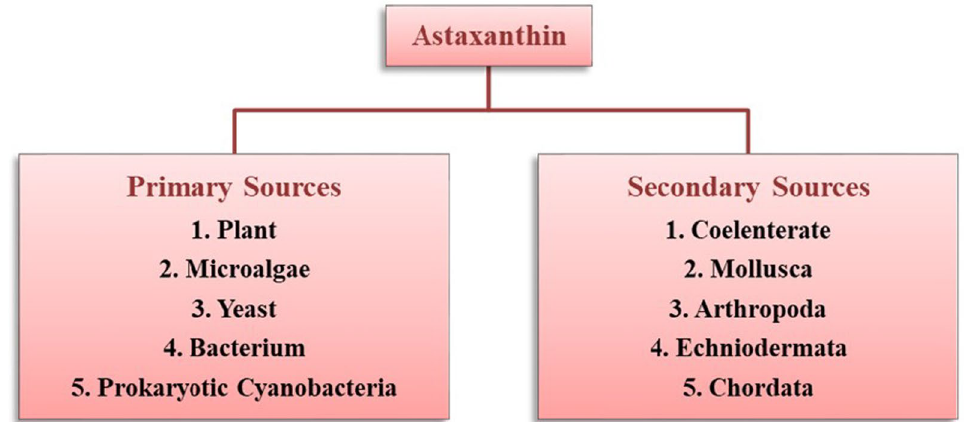
Fig. 4 Natural sources of astaxanthin